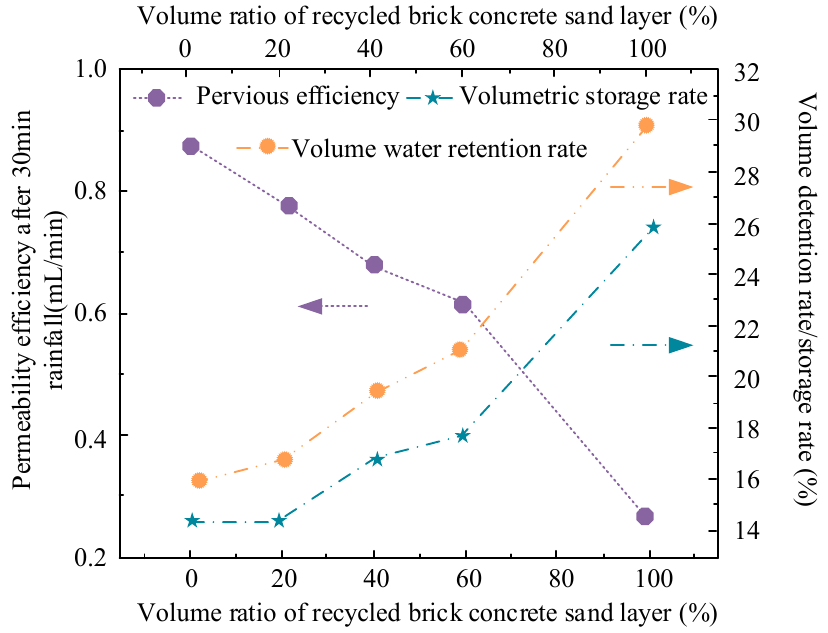
Figure 6. Influence of different gradation on permeability and storage performance of materials.